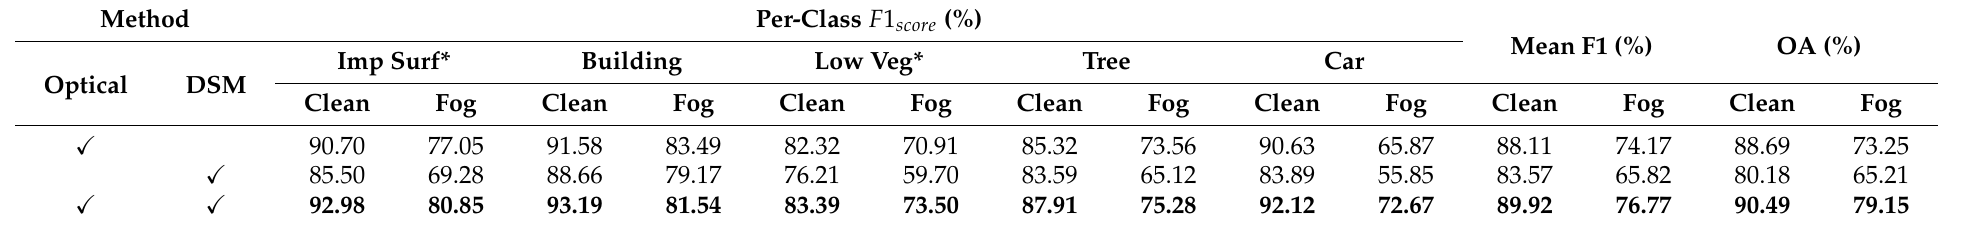
Table 5. Quantitative evaluation for clean and fog corrupted variants of the Vaihingen test set about using different input data. Every F 1 score is averaged over all five severity levels. The best results are marked in bold.